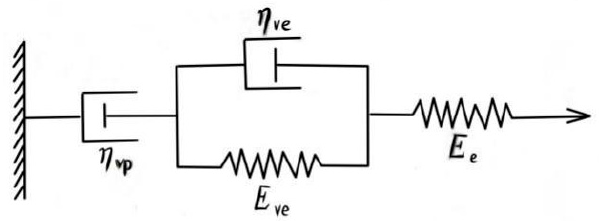
Figure 10. Improved Burgers model.